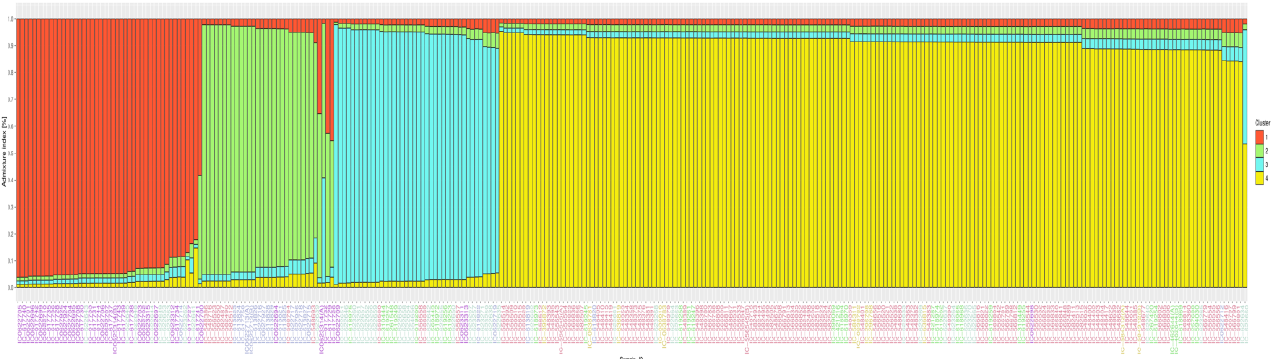
Figure 4. fastSTRUCTURE bar plot showing the population number (K = 4) of 298 rice landraces using SSR